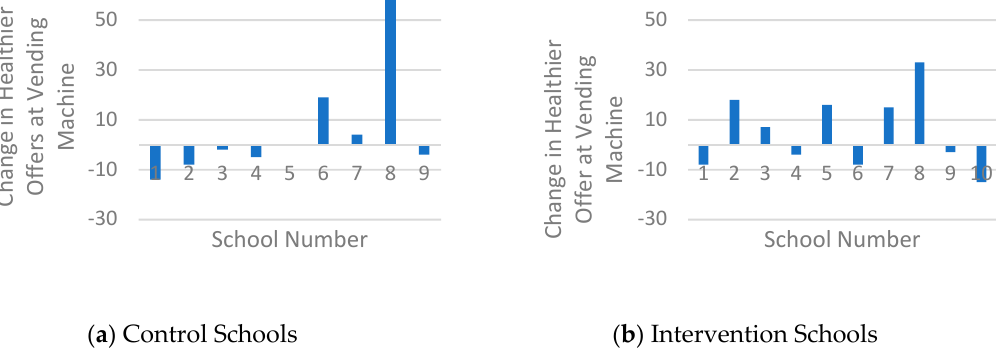
Nutrients 2020 , 12 , x FOR PEER REVIEW Figure 3. Histogram of the changes in healthier products available at vending machines. Figure 3. Histogram of the changes in healthier products available at vending machines. Figure 3. Histogram of the changes in healthier products available at vending machines.